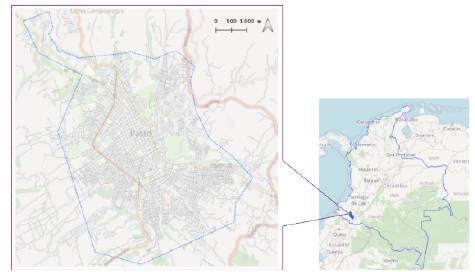
Figure 3. Overview of the city of Pasto, Department of Nariño, in southern Colombia (base map from OpenStreetMap ® ).